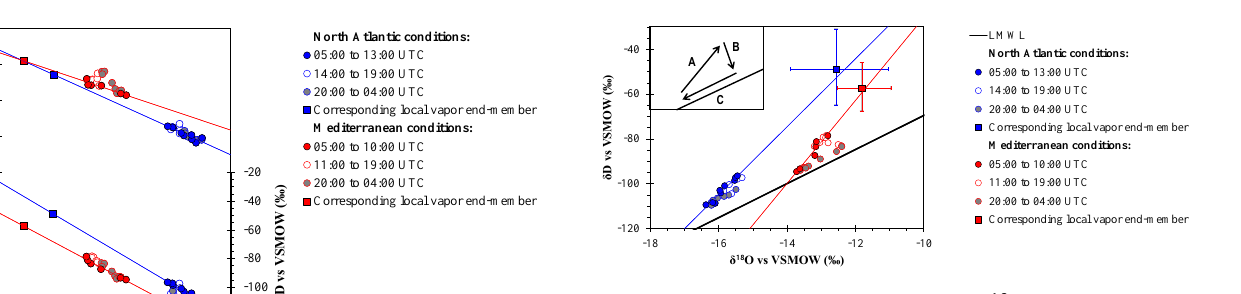
Figure 7. Hourly average values of δ D vs. δ 18 O over a daily cycle, according to the two main air mass origins, corresponding linear regressions for the period of q increase (see text), and calculated local end-member ( δ E ). For reference, the LMWL is also